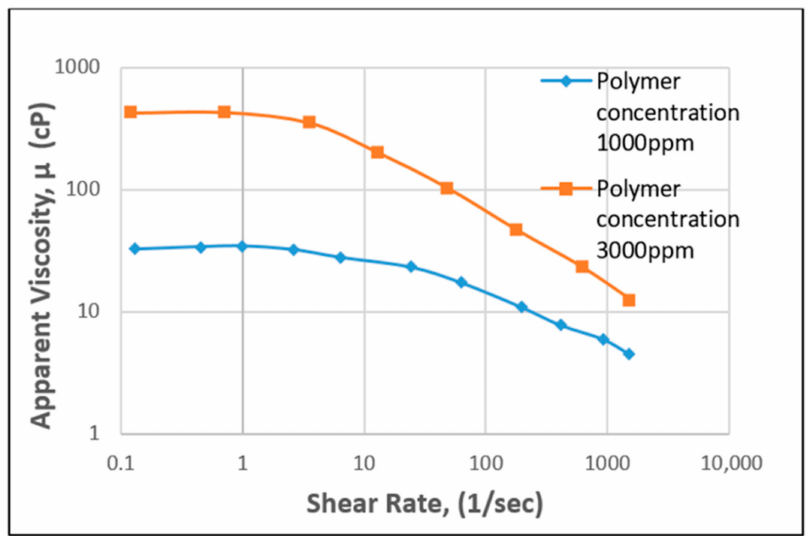
Figure 9. Apparent viscosity vs. shear rate for XG. Reprinted and modified from